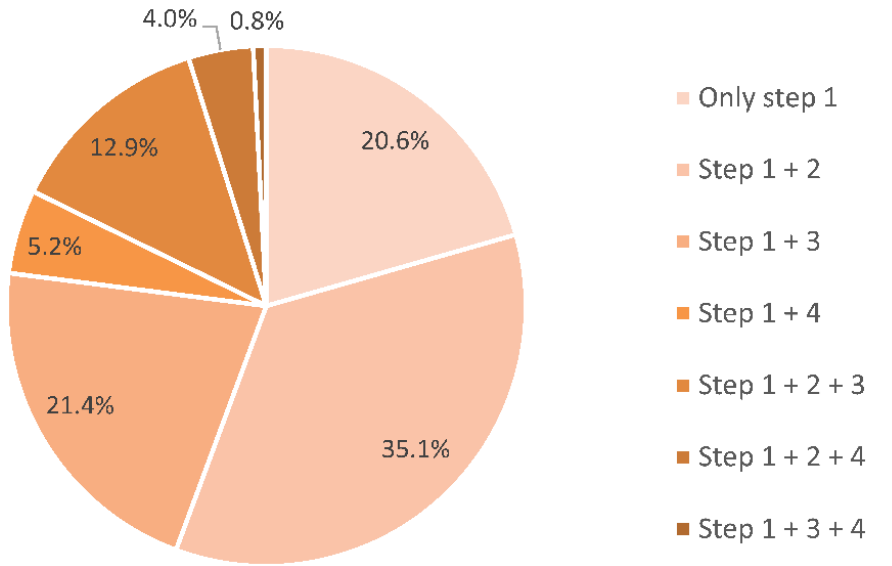
Figure 4. Percentage of articles categorized according to STEPLand steps. Source: own elaboration.